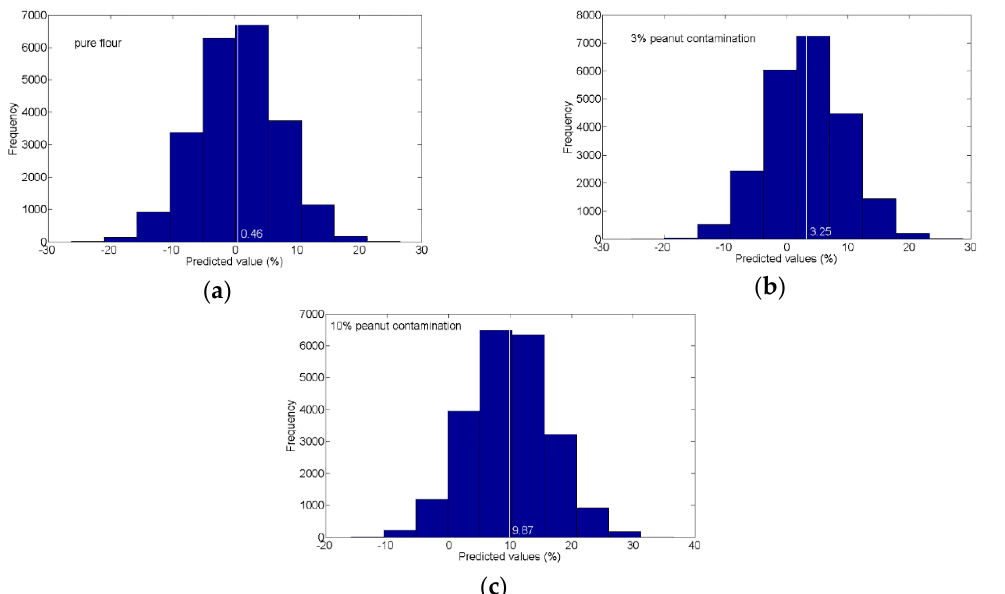
Figure 5. Histogram of frequency of predicted results of the pixels of peanut-contaminated samples in concentrations of 0% ( a ); 3% ( b ); and 10% ( c ) based on the multispectral model using the 16 wavelengths.